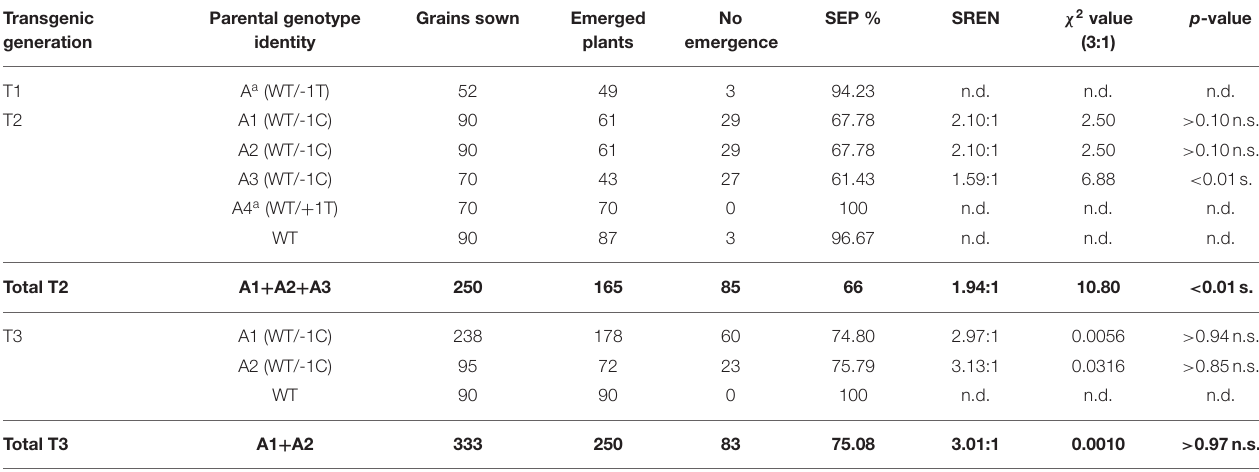
TABLE 2 | Seedling emergence of the T1, T2, and T3 progeny of the line A. Transgenic